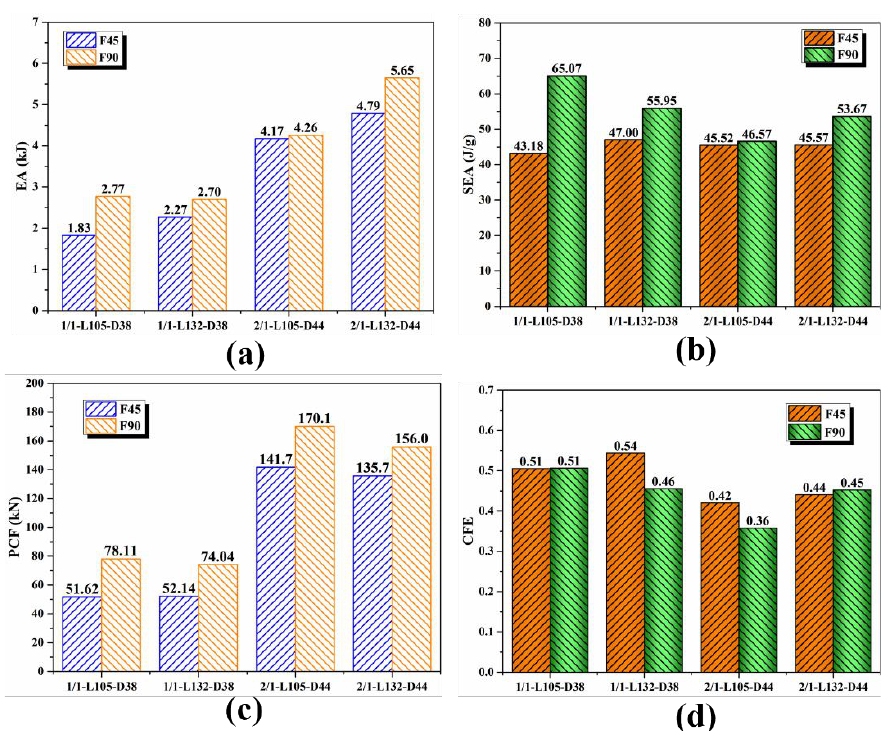
Figure 14. Comparison of energy-absorption performance between 1/1 and 2/1 hybrid tubes: ( a ) EA ; ( b ) SEA ; ( c ) PCF ; ( d ) CFE .